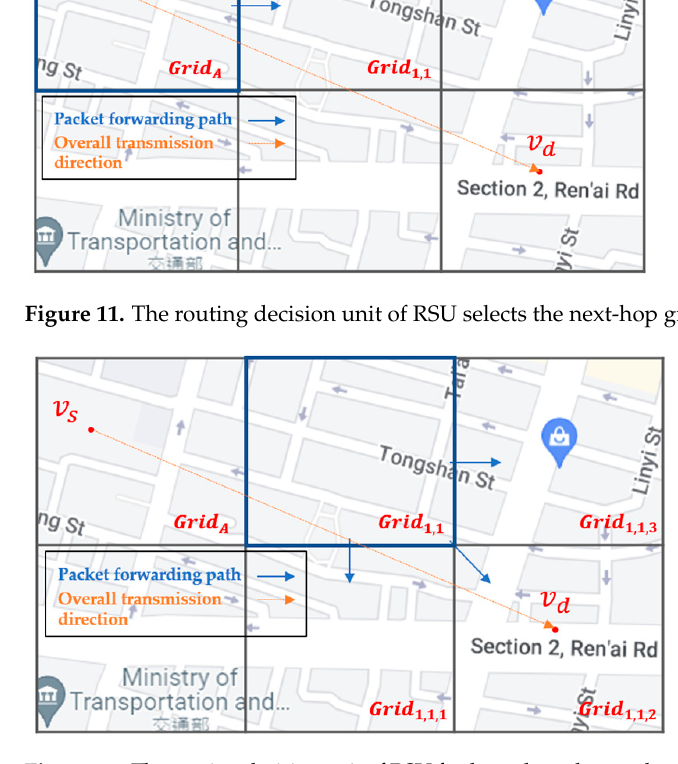
Figure 12. The routing decision unit of RSU further selects the two-hop next grid, using the next-hop grids. Algorithm 2 refers to the next-hop grid and the two-hop next grid